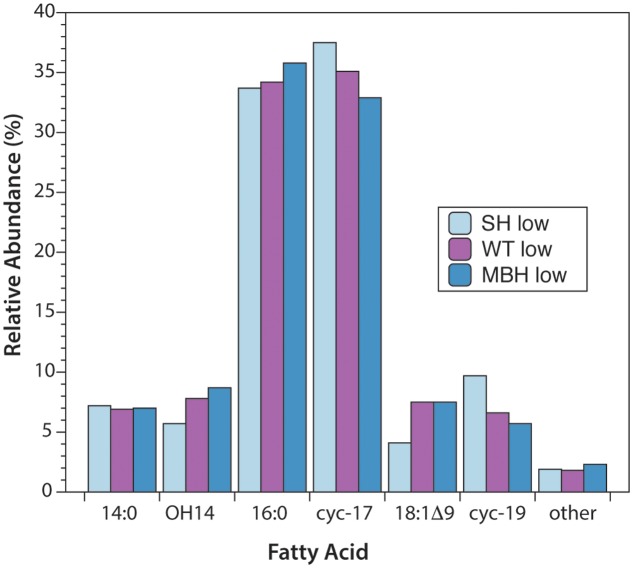
Relative abundances of fatty acids from the three strains of C. necator, all grown in non-D-enriched medium. Colors represent the SH- (light blue), wild-type (purple), and MBH- (dark blue) strains.